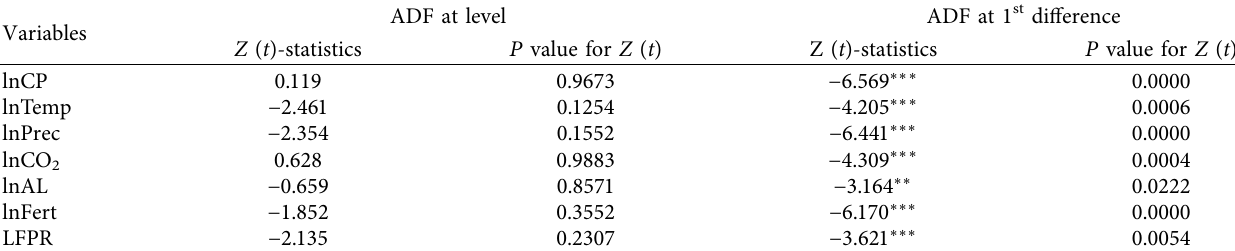
Table 3: Results of the stationarity test.